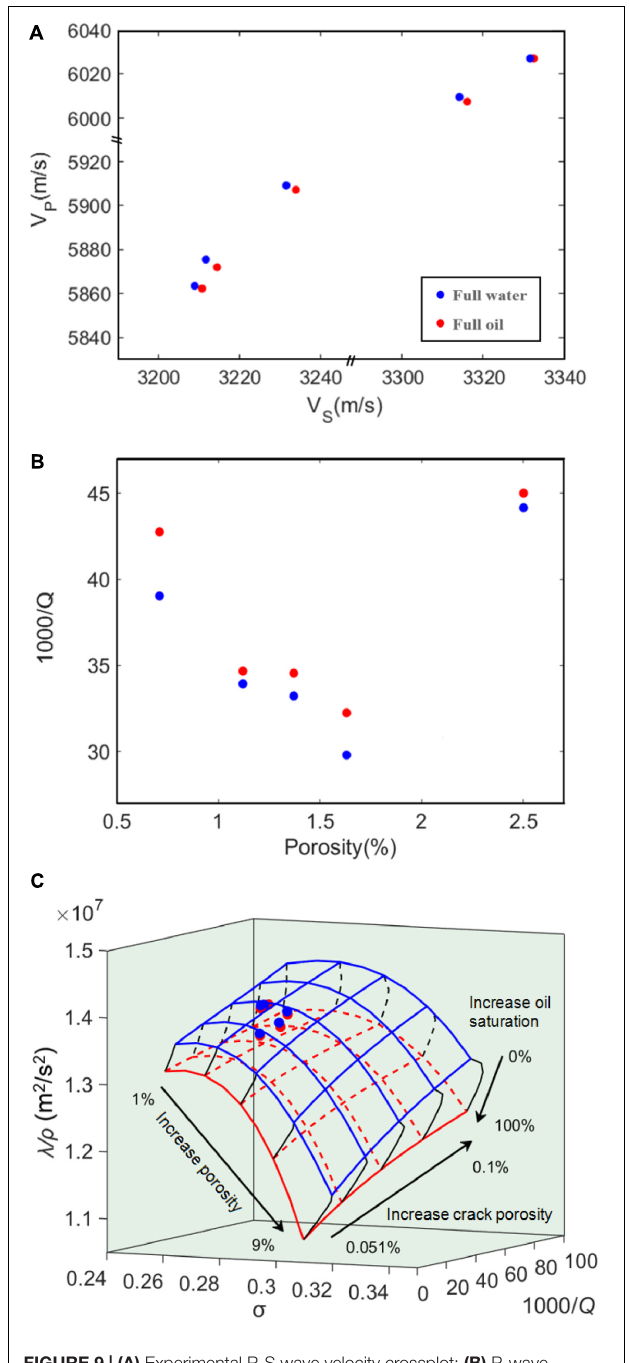
FIGURE 9 | (A) Experimental P-S wave velocity crossplot; (B) P-wave dissipation factor as a function of the total porosity; (C) 3D RPT at 1 MHz compared to the experimental data. The blue and red dots refer to the samples saturated with water and oil,